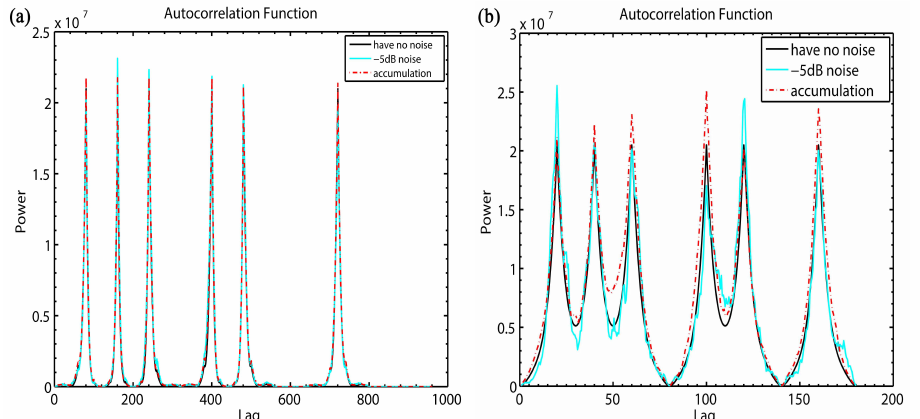
Figure 8. ( a ) Autocorrelation function of 4-bit strong alternating code modulated by 16-bit comple- mentary code and ( b ) Autocorrelation function of 16-bit strong alternating